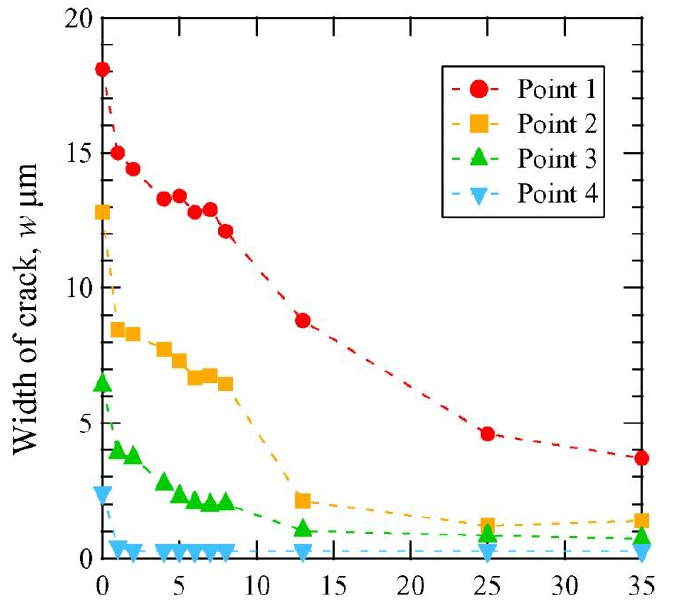
Figure 7. Crack width at the measuring point in Figure 5 as a function of the number of applications of electropulsing in Sample